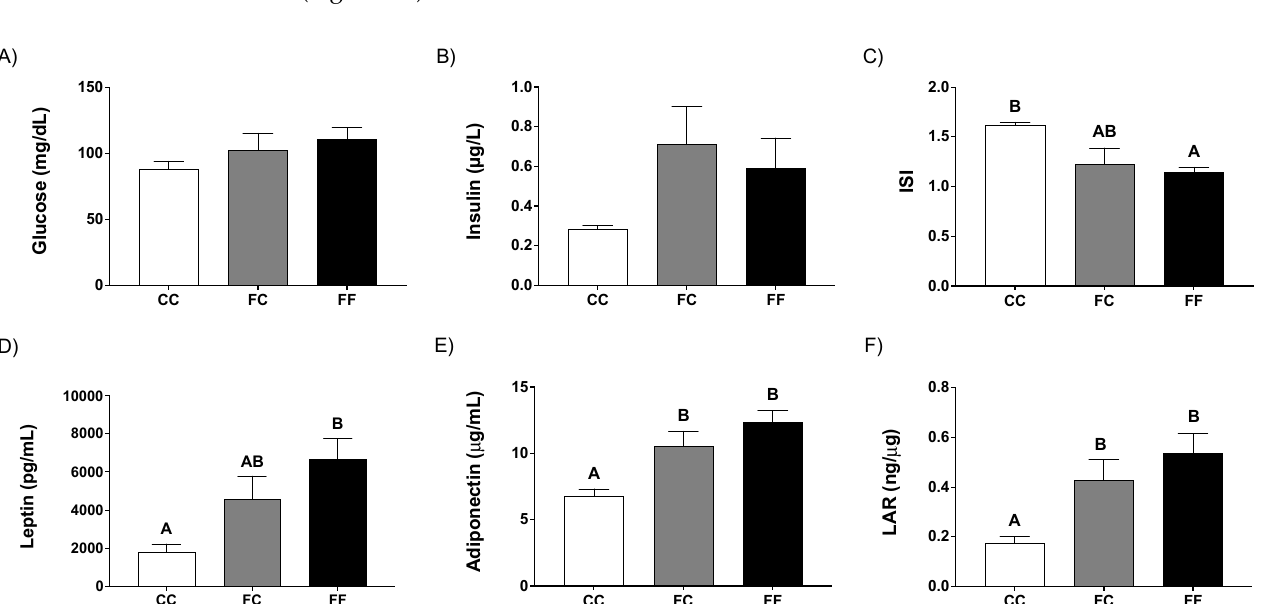
Figure 2. Pregnancy in progeny from fructose-fed mothers and ingestion of a 10% wt/vol fructose solution throughout gestation in pregnant rats from fructose-fed mothers affects maternal leptin and insulin responses. Plasma ( A ) glucose and ( B ) insulin, and ( C ) insulin sensitivity index (ISI) of 21-day-pregnant rats from control mothers (CC, empty bar), or pregnant rats from fructose-fed mothers subjected (FF, black bar) or not (FC, grey bar) to fructose intake throughout pregnancy. Plasma ( D ) leptin and ( E ) adiponectin, and ( F ) leptin/adiponectin ratio (LAR) of 21-day-pregnant rats from control mothers (CC, empty bar), or pregnant rats from fructose-fed mothers subjected (FF, black bar) or not (FC, grey bar) to fructose intake throughout pregnancy. Data are mean ± S.E. from 5 pregnant rats. Values not sharing a common letter are significantly different ( p < 0.05) between the three groups.